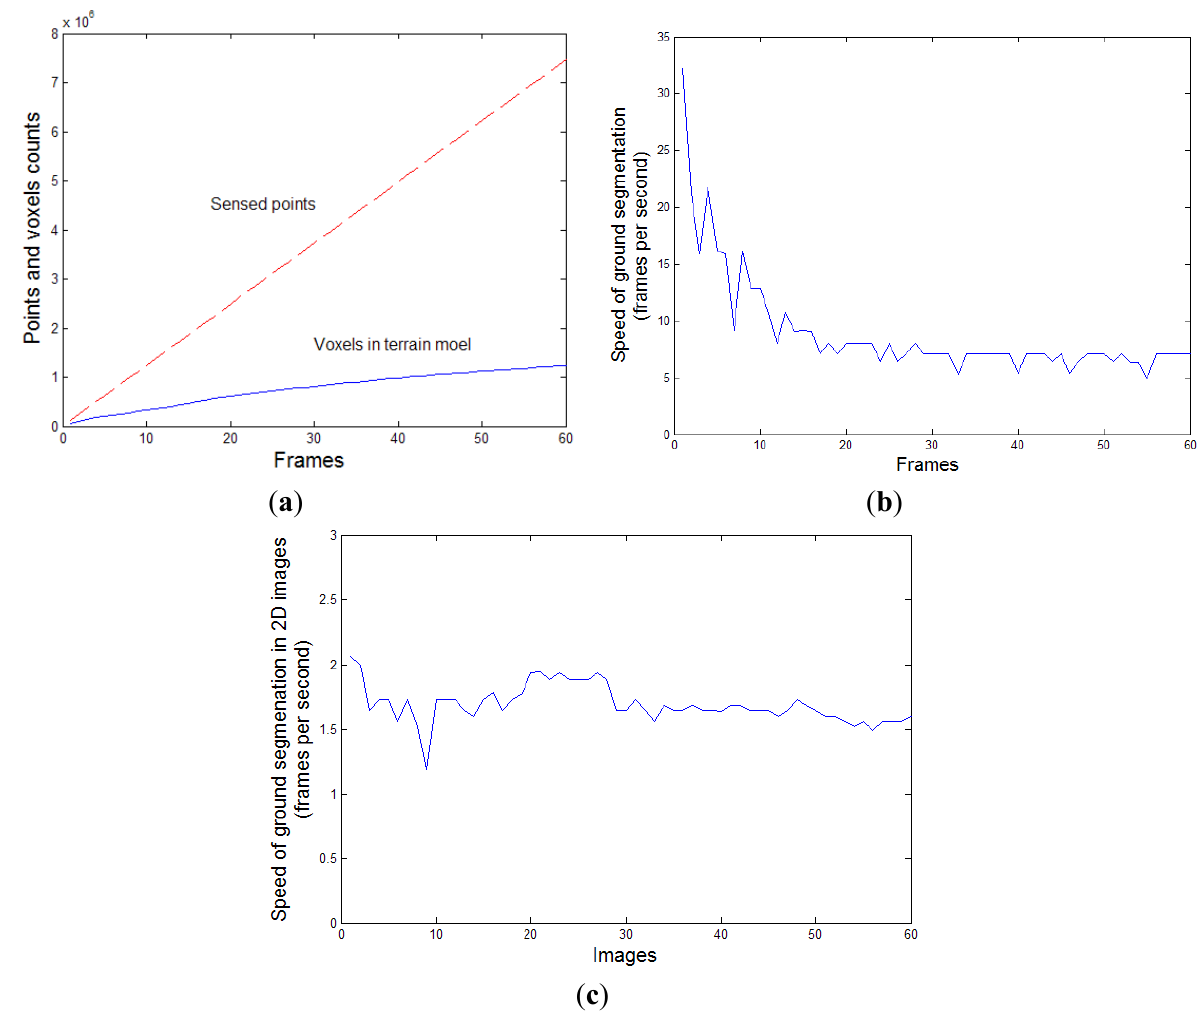
Figure 11. Ground segmentation performance over frames 1~60. ( a ) Number of sensed points and processed voxels. ( b ) Speed of ground segmentation for the voxel